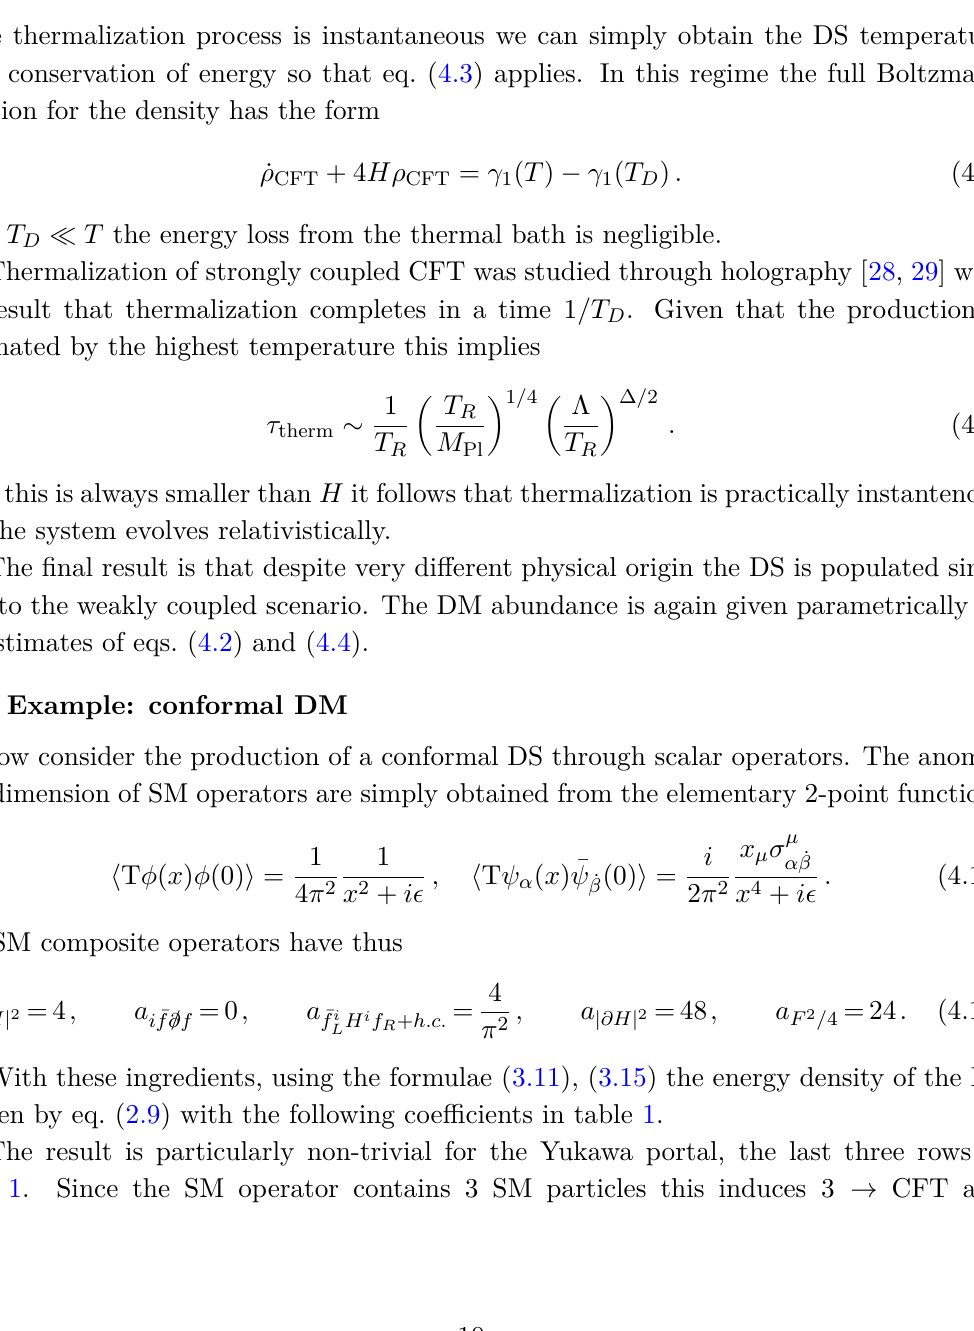
Table 1 . Production rate coefficients for portal interactions with SM singlets and CFT operators of various